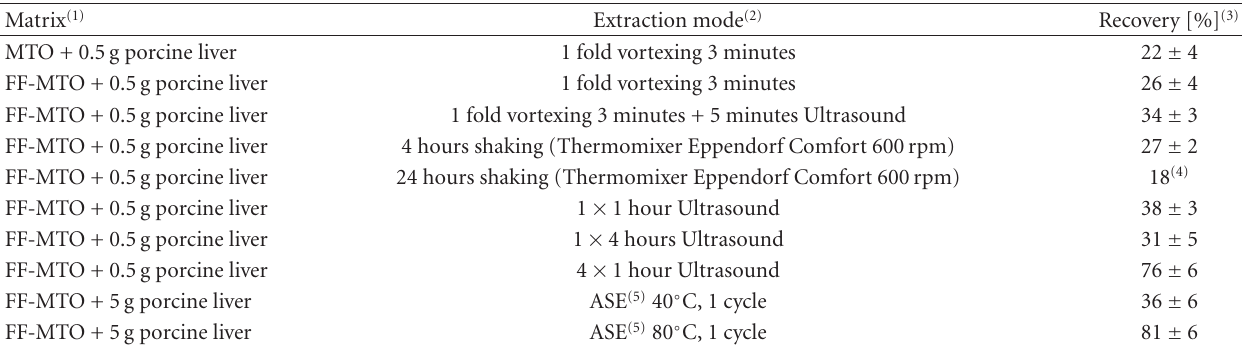
Table 2: Comparison of di ff erent extraction techniques.